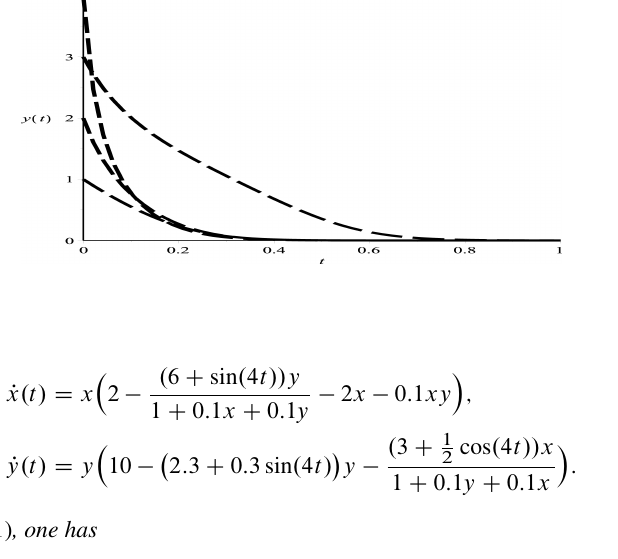
Fig. 4. Dynamic behavior of the second component y.t/ of the solution .x.t/;y.t// of system (61) with the initial conditions .x.0/;y.0// D .1;1/ , .2;2/ , .0:2;3/ and .7;4/ ,